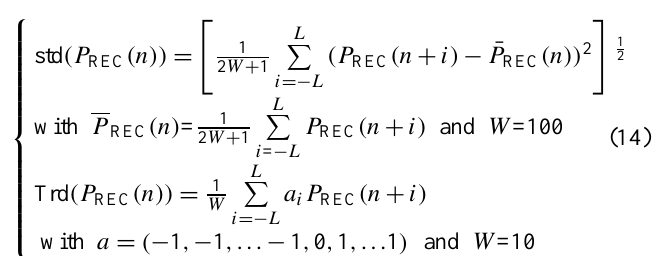
over a 4 min time